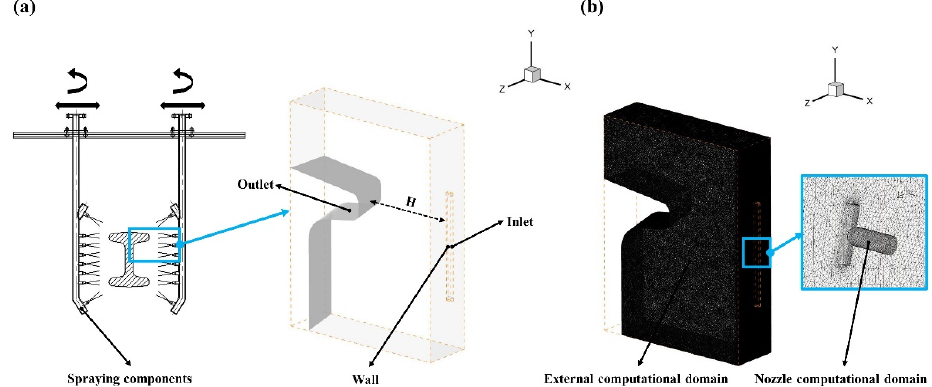
Figure 6. A schematic diagram of the local physical model and meshing of the special-shaped hot forging: ( a ) physical model; ( b ) unstructured grid meshing.